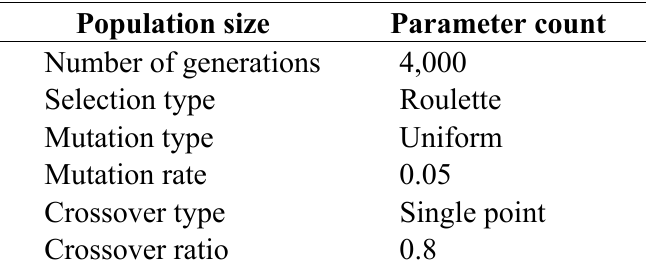
Table 2. Control parameters of